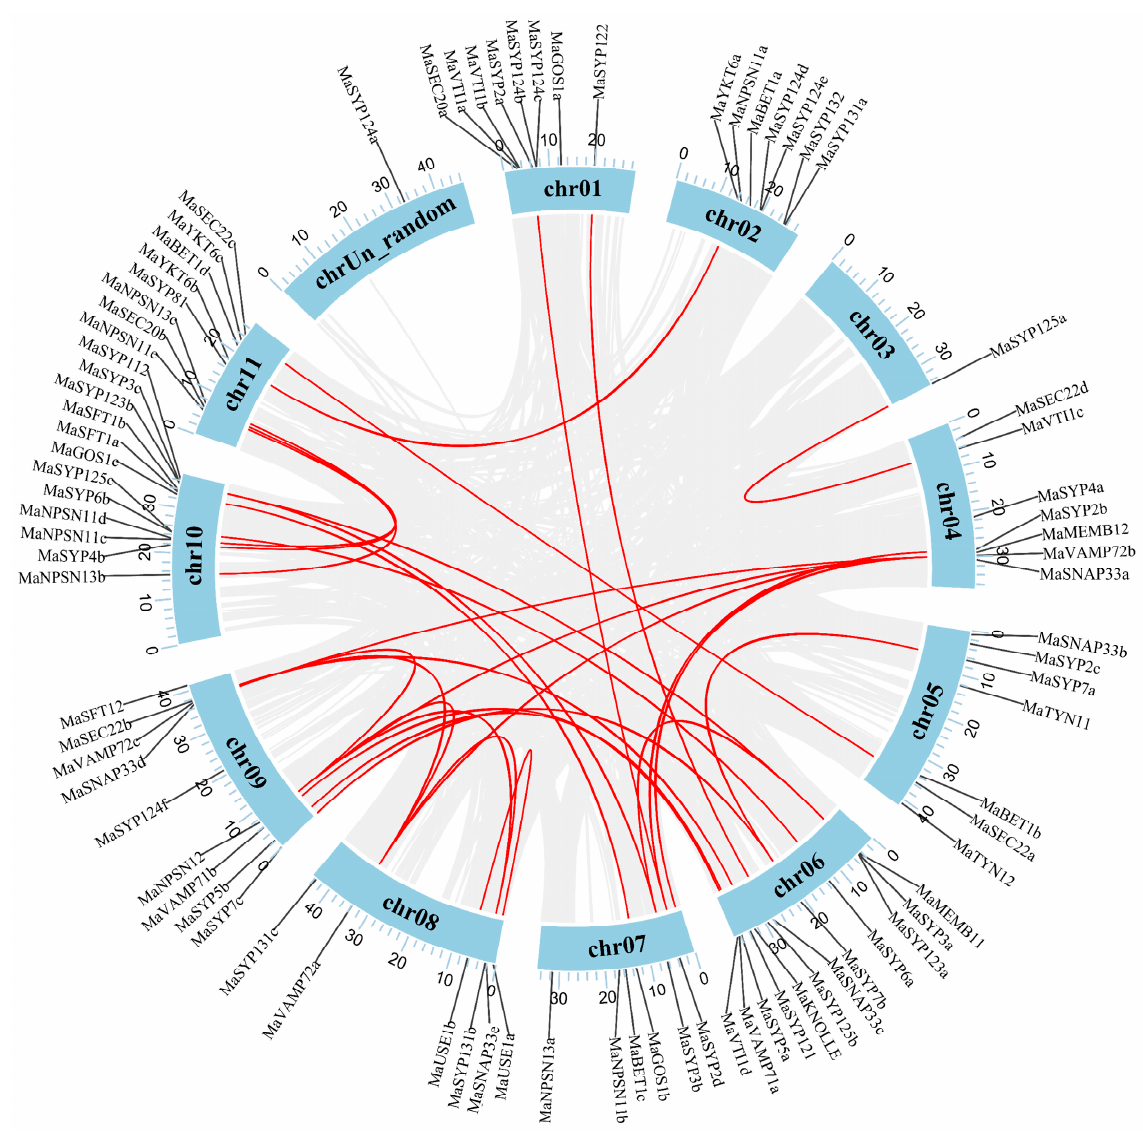
Figure 4. Chromosome localization and collinear distribution analysis results of MaSNAREs . Chr: chromosome; Ma: Musa acuminata . The gray lines represent segmental duplicated gene pairs in the whole banana genome; the red lines represent segmental duplicated MaSNAREs gene pairs.